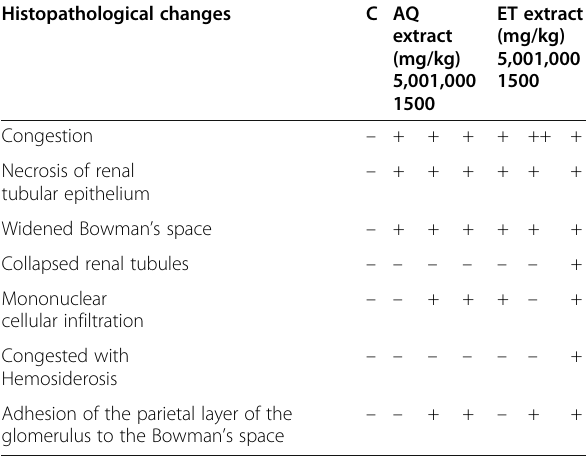
aqueous and ethanolic extract of Spondias purpurea leaf Histopathological changes C AQ